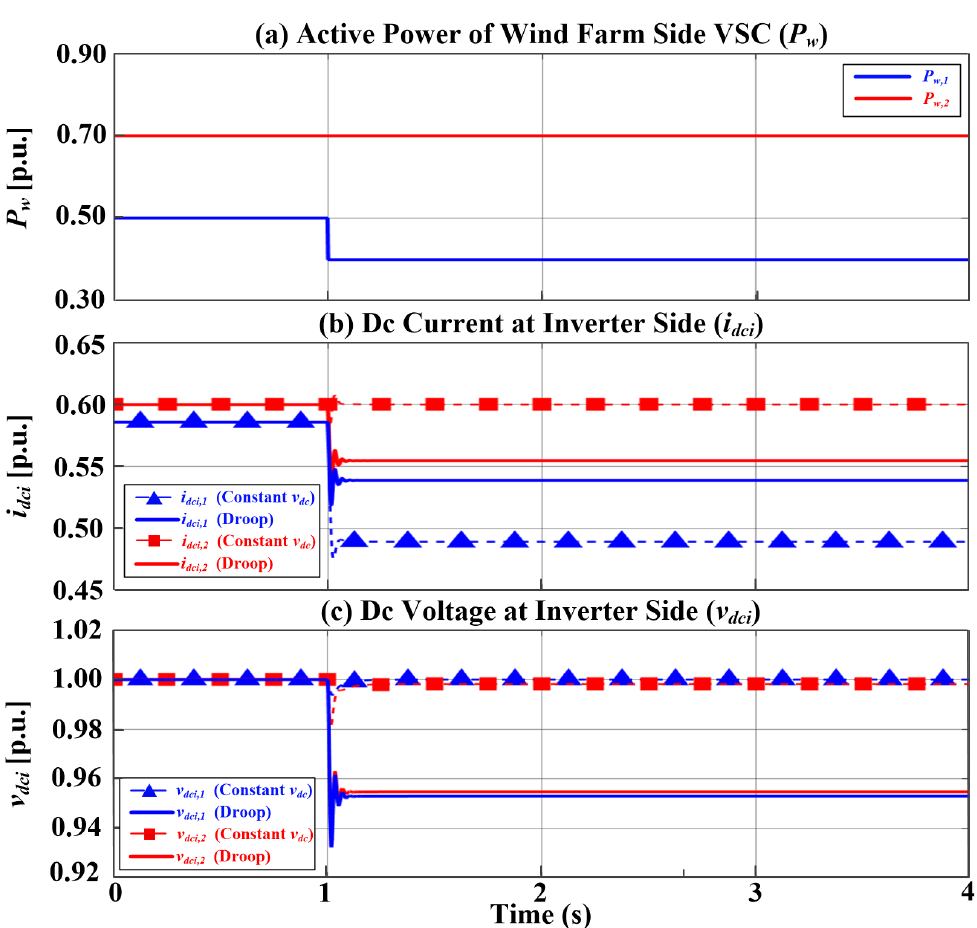
Figure 12. The responses of the hybrid MTDC systems for the stepped wind power change using the two control methods: master–slave control and voltage droop control. ( a ) Wind power at VSC sides, P w ; ( b ) dc current at inverter side, i dci ; and ( c ) dc voltage at inverter sides, v dci